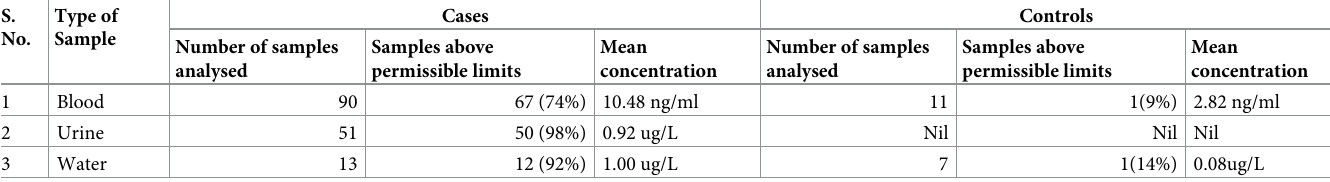
Table 2. Percentage of pesticide identified in blood, urine and household water samples of cases and controls. S. Type of No.